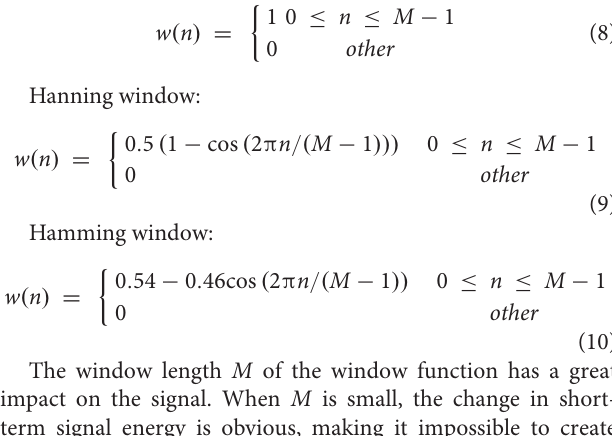
clips. In the music, there are 60 pieces of music for each instrument used for training: 20 for verification and 20 for testing.